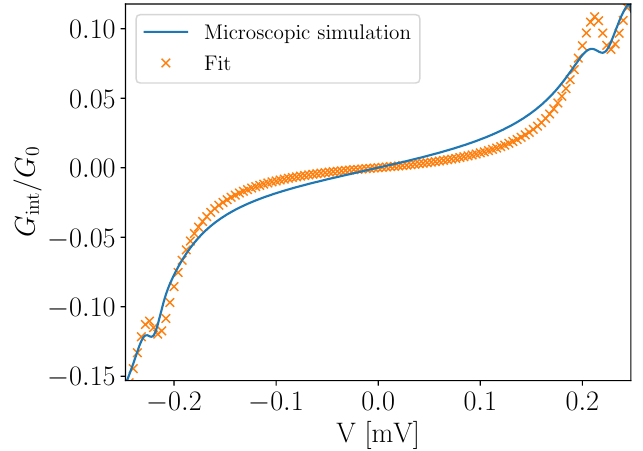
Figure 10: Blue line: integral term of the conductance for the system shown in = 0. Orange dots: fit to integral term expression obtained from Fig. 10(a) at V Z two-level toy